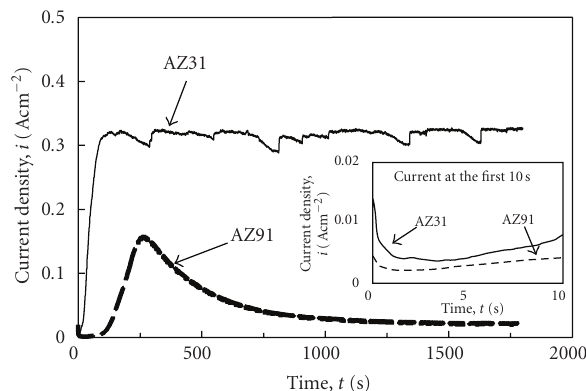
Figure 7: Current density during anodizing at 3 V in 1MNaOH